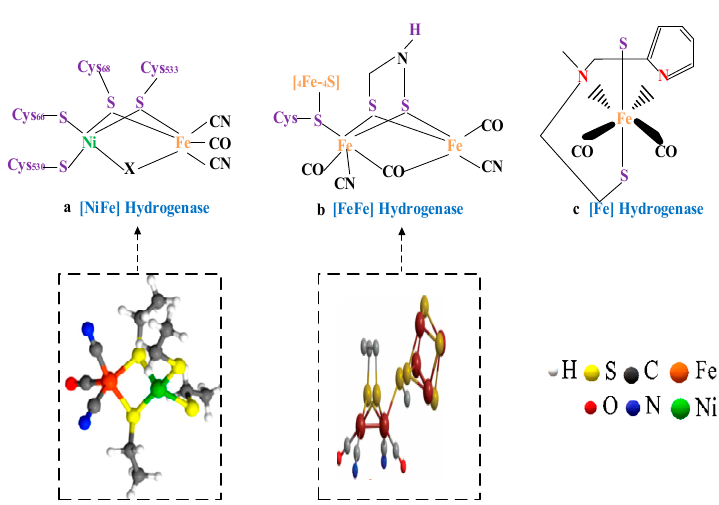
Figure 2. Schematic structure of different types of hydrogenase: ( a ) [NiFe] hydrogenase; ( b ) [FeFe] hydrogenase; and ( c ) [Fe] hydrogenase. The figure was adapted and rearranged from Fontecilla-Camps et al. [29].